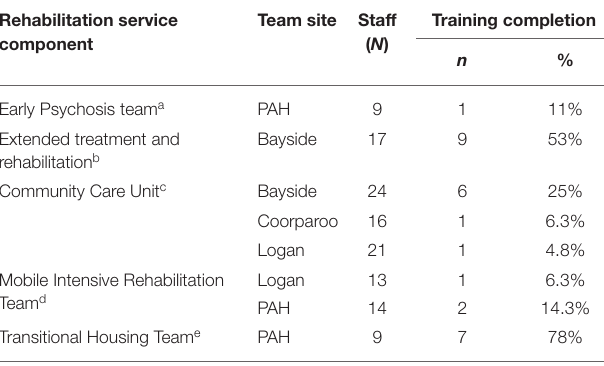
TABLE 1 | Rehabilitation team descriptions and training completion